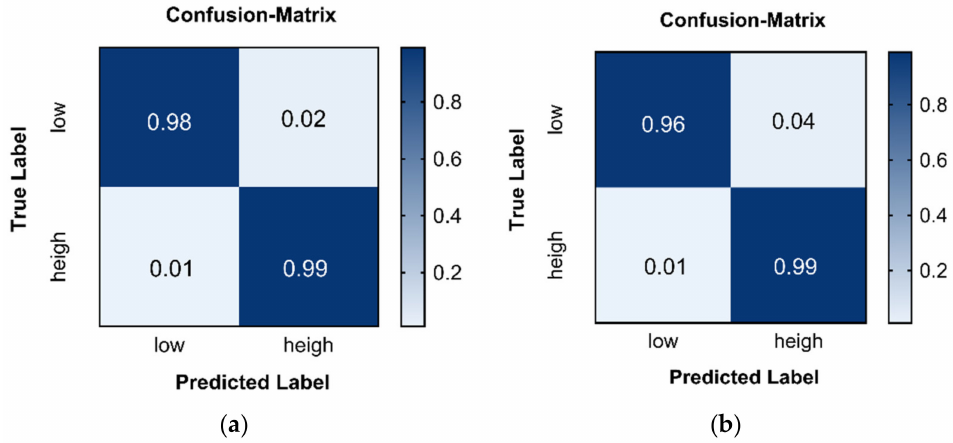
Figure 9. Confusion matrices of our method on Arousal ( a ) and Valence ( b ).